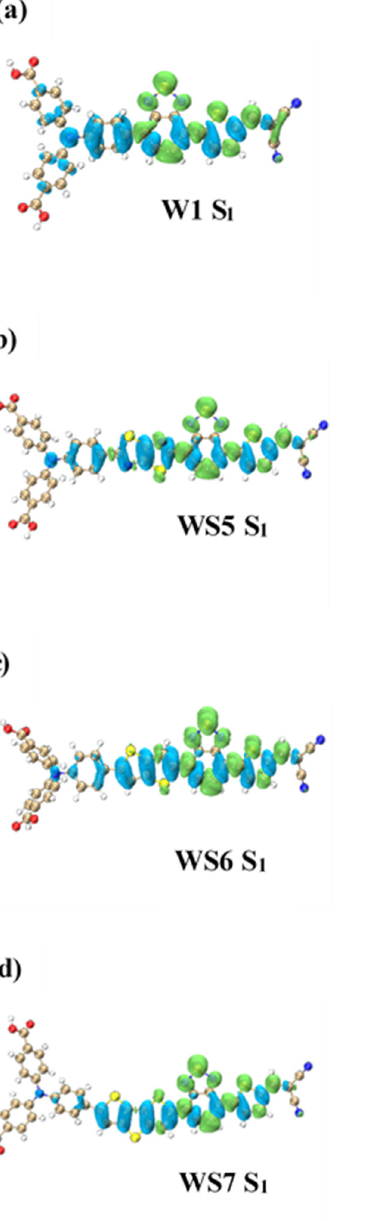
Figure 5. TDM and CDD of S 1 of ( a ) W1, ( b ) WS5, ( c ) WS6, and ( d ) WS7 in OPA process. The blue isosurface represents holes, and the green isosurface represents electrons.